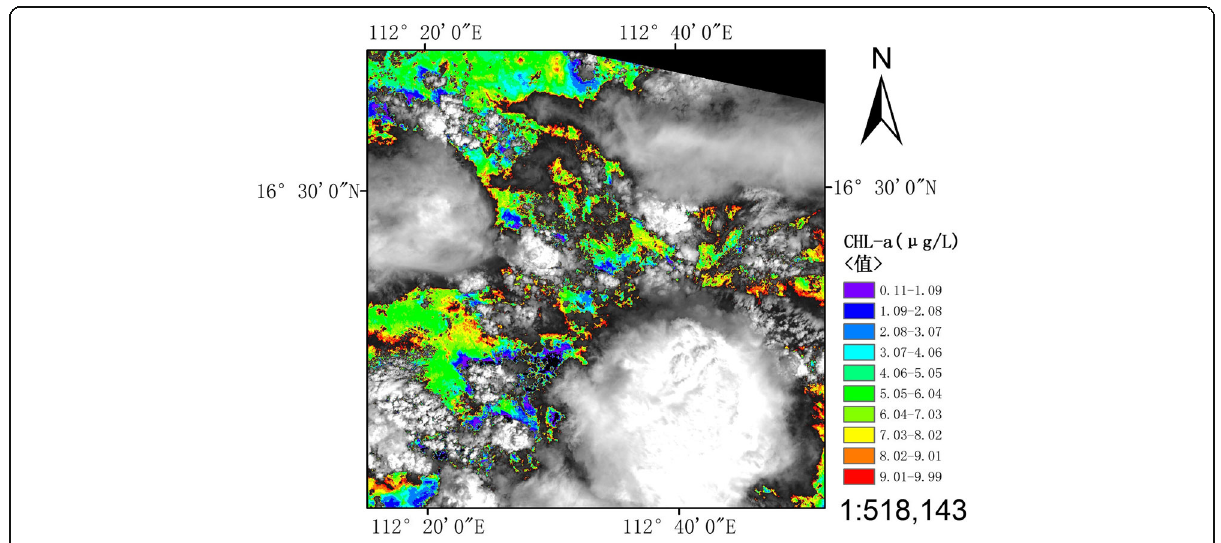
Fig. 17 The relationship between CHL-a value, wind speed, and typhoon